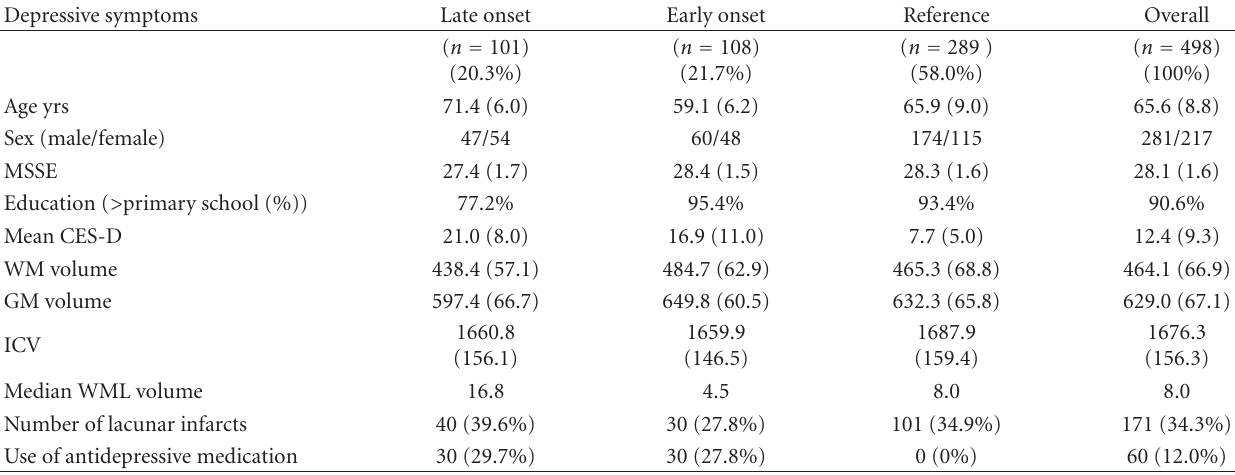
Table 1: Baseline Characteristics of patients with Late Onset Depressive Symptoms (LODSs), Early Onset Depressive Symptoms (EODSs), and patients without depressive symptoms.